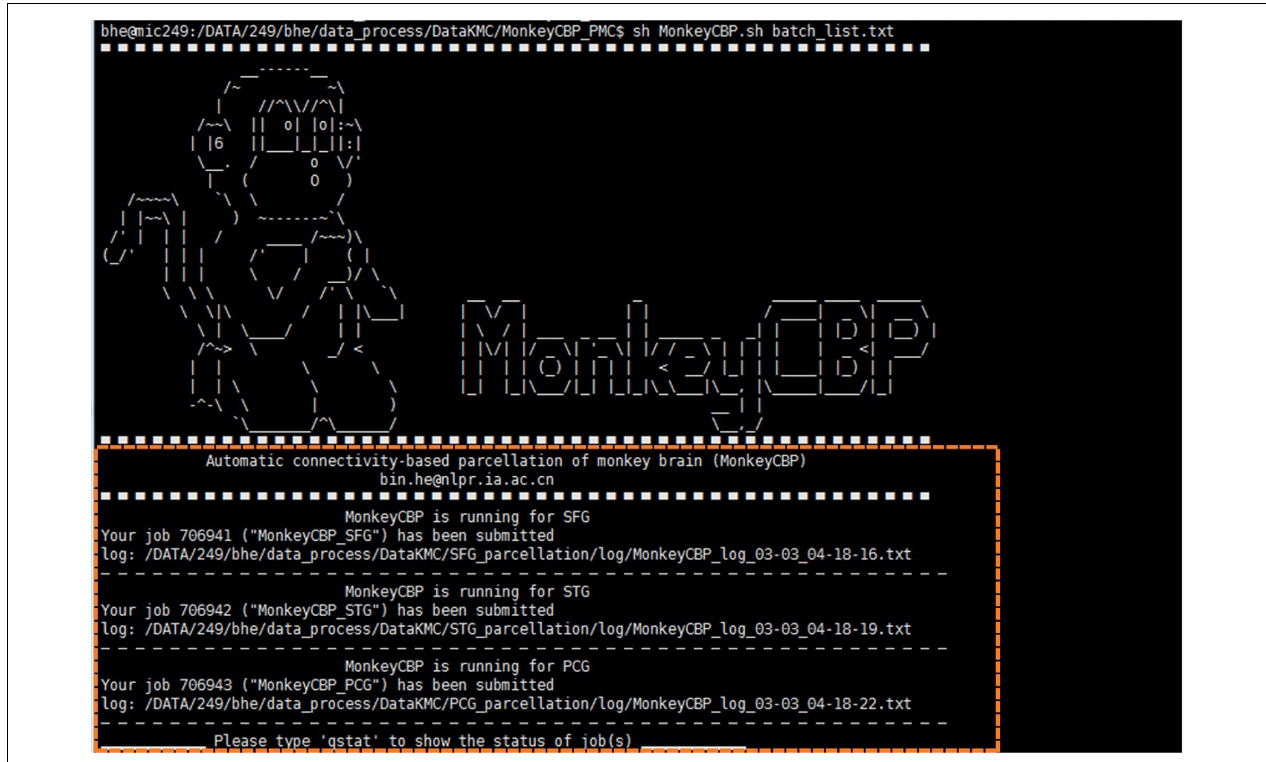
FIGURE 4 | Command line (CLI) version of MonkeyCBP. CLI version is multi-region of interest (ROI) oriented; therefore, users could parcellate multiple brain regions synchronously. The diagram shows that the user submitted three concurrent tasks for the parcellations of superior frontal gyrus (SFG), superior temporal gyrus (STG), and posterior cingulate gyrus (PCG) at the same